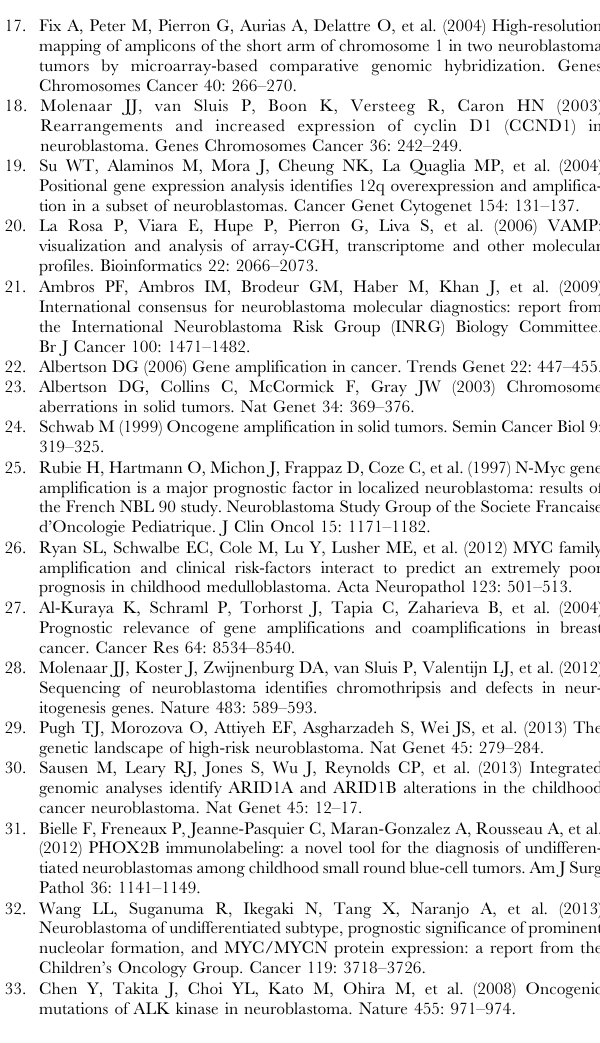
Table S1 Boundaries for amplifications found in group 1 and in group 2. Boundaries of one amplified region are given according to the genomic position of the markers (BAC or oligonucleotide probe) located outside the amplified region (coordinates of the non amplified markers closest to the